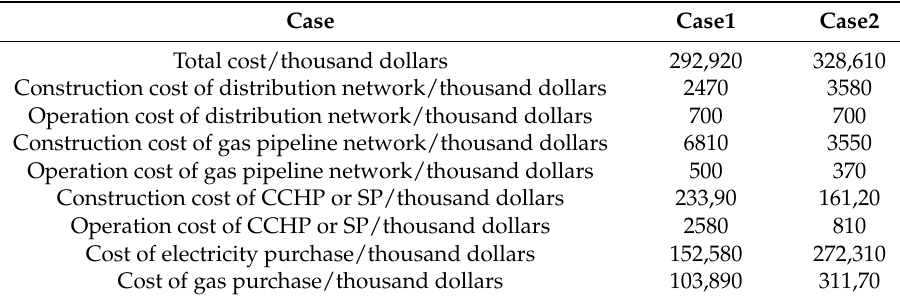
Table 2 . Cost comparison for cases. Table 2. Cost comparison for cases.